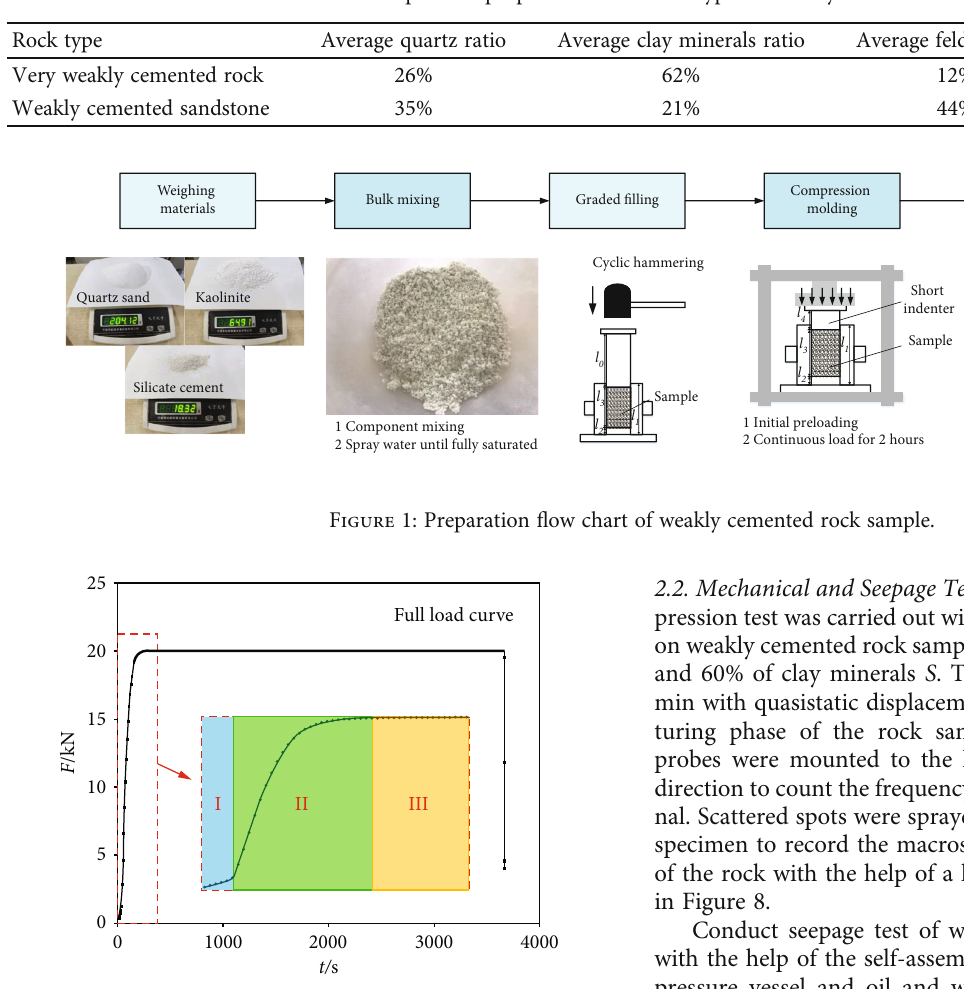
Table 1: Composition proportion of di ff erent types of weakly cemented rocks.